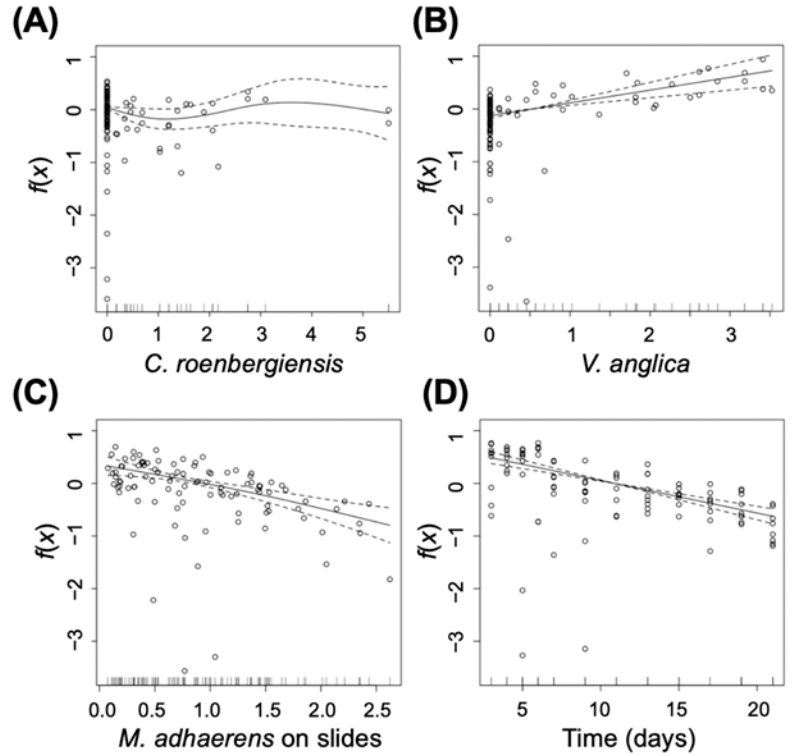
Figure 1. Predator–prey dynamics comparing bacteria population dynamics in the water ( A , D ) and attached to surfaces ( B , E ) in presence of ( A – C ) the planktonic predator (blue), or ( D – F ) the surface-attached predator (red) with the corresponding dynamics observed in the control treatment (black line). ( C , F ) show the total cell density (light blue solid line) of the planktonic C. roenbergensis (( C ), blue) and the total cell density per total surface area (red solid line) of the surface-attached V. anglica (( F ), red, respectively. The vertical dashed black line marks the addition of the respective predator on day 2 of the experiment.